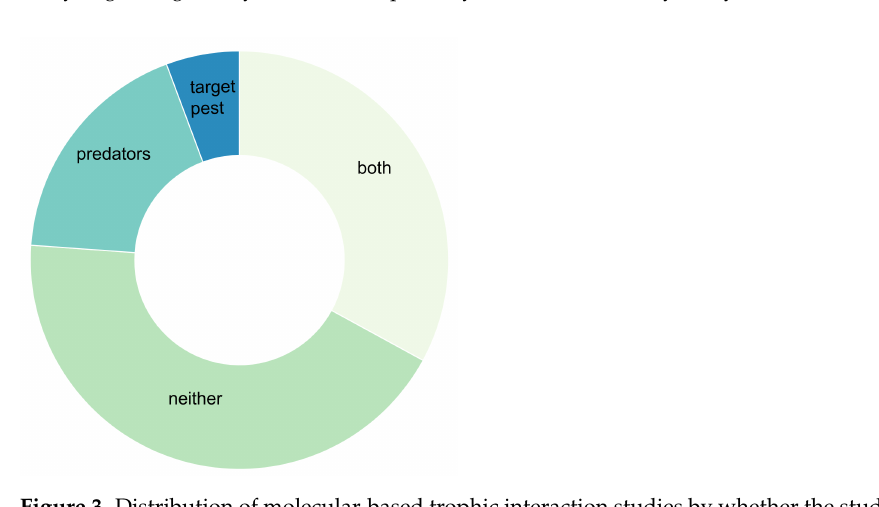
Figure 2. Distribution of molecular trophic interactions in agricultural systems by system ( A ), and the scale at which the study was conducted ( B ). The abbreviations in ( A ) indicate: noncrop = non crop habitat, smfr = small fruit, agri = agricultural landscapes, spec = specialty crops, trfr = tree fruit, and agro = agronomic crops. The abbreviations in ( B ) indicate: lab = laboratory study, grh = greenhouse study, cage = cage study, lds = landscape study, lab&fd = laboratory study combined with field study.